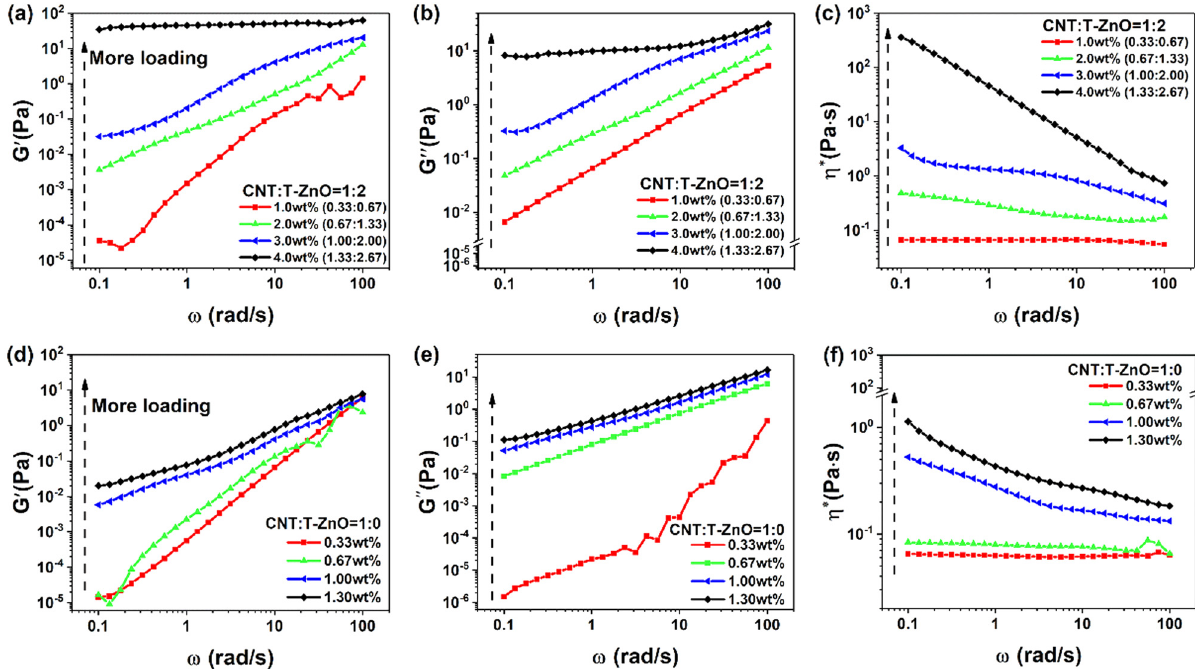
Figure 3: Storage modulus G ′ , loss modulus G ″ , complex viscosity η * of the epoxy - based nanocomposites as a function of angular